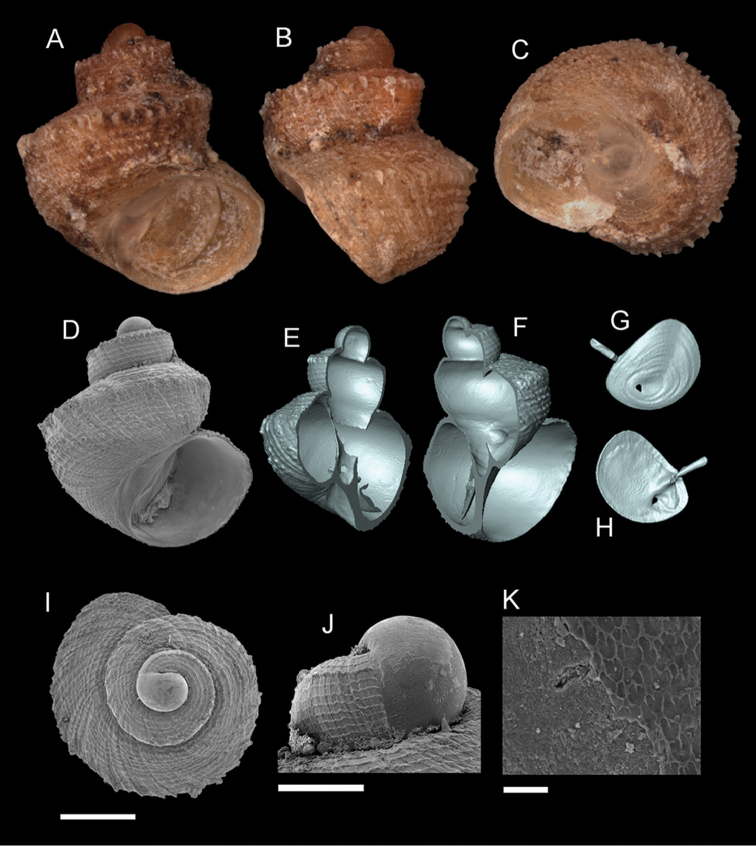

Georissa
scalinella (van Benthem-Jutting, 1966). A–C Holotype: ZMA/MOL/ 135736 D–K Paratypes: ZMA/MOLL 135735. A, D Shell apertural view B Shell side view C Shell rear view E–F Shell cross-section from 3D model G–H Operculum frontal and ventral view I Shell top view J Protoconch side view K Close up of protoconch from top at 1000× magnification. Scale bars: 500 µm (A–I); 200 µm (J); 10 µm (K).